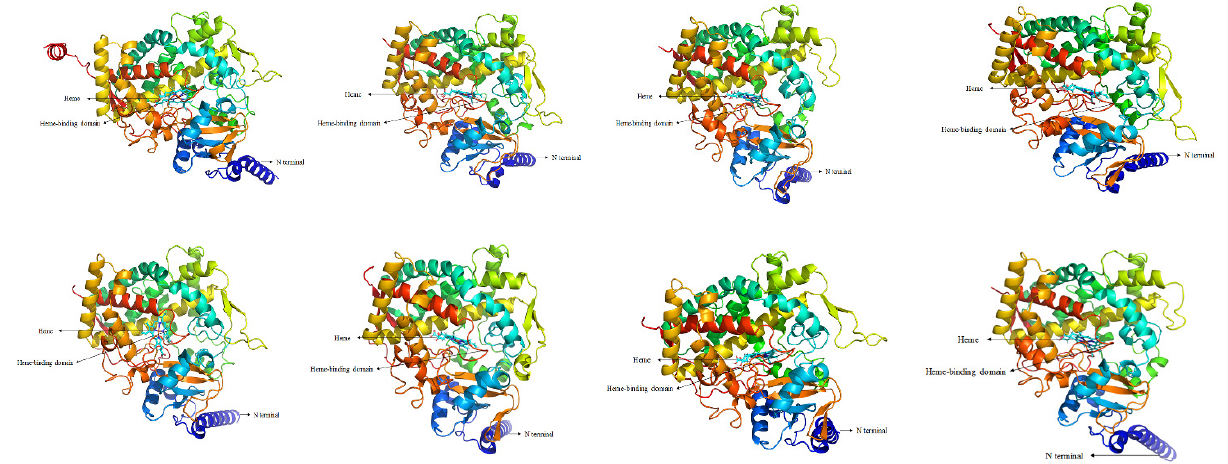
Figure 1. Predicted tertiary structures of eight CYP6 genes from G. molesta . Image colored by rain- bow N-C terminus. (Supplementary File